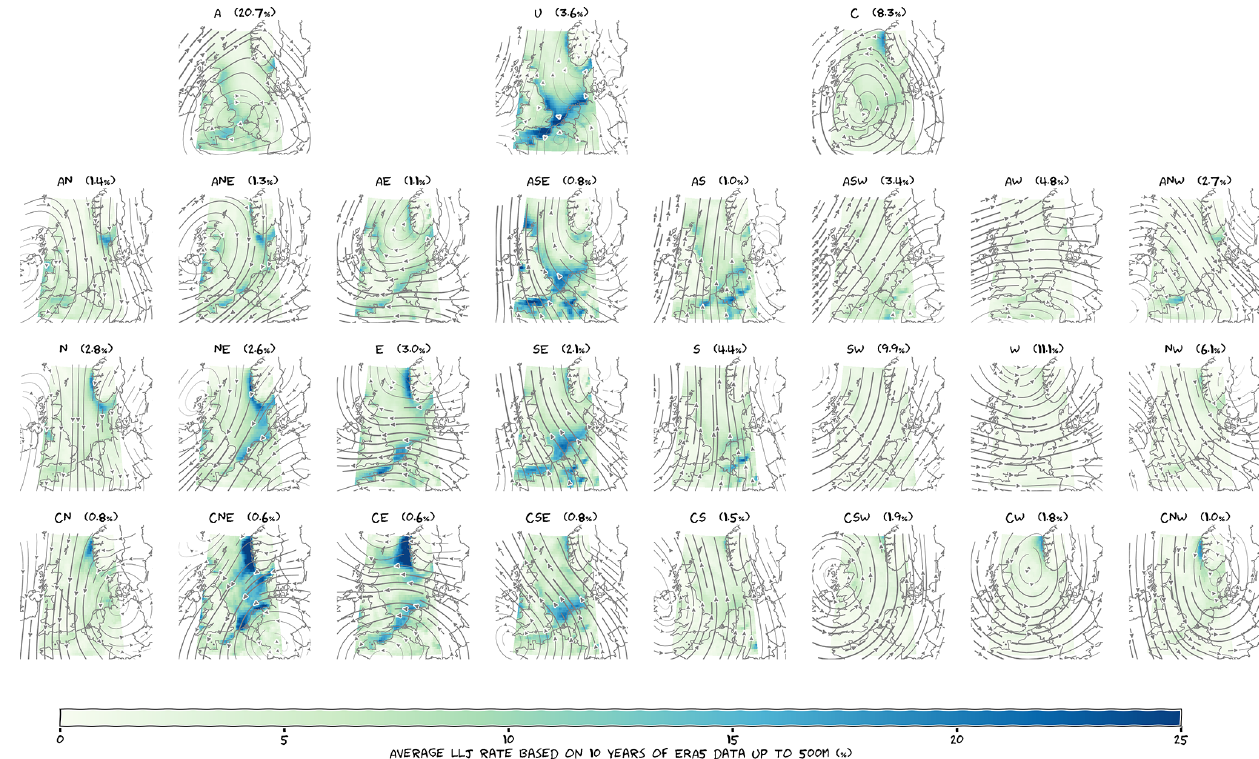
Figure 9. Spatial distribution of the low-level jet rate in ERA5 data. As explained in the text, the values shown here overestimate available observations and should be interpreted with caution. A: anticyclonic; C: cyclonic; U: undefined; N, NE, E, etc., are eight wind direction sectors; combinations of a direction and a rotation type are “hybrid” weather types, while weather types without a dominant rotational component are “pure directional”. Streamlines illustrate the dominant large-scale flow pattern (averaged over each LWT). The relative occurrence of each weather type is indicated as well. The figure can be enlarged for more detail or downloaded separately from the article web